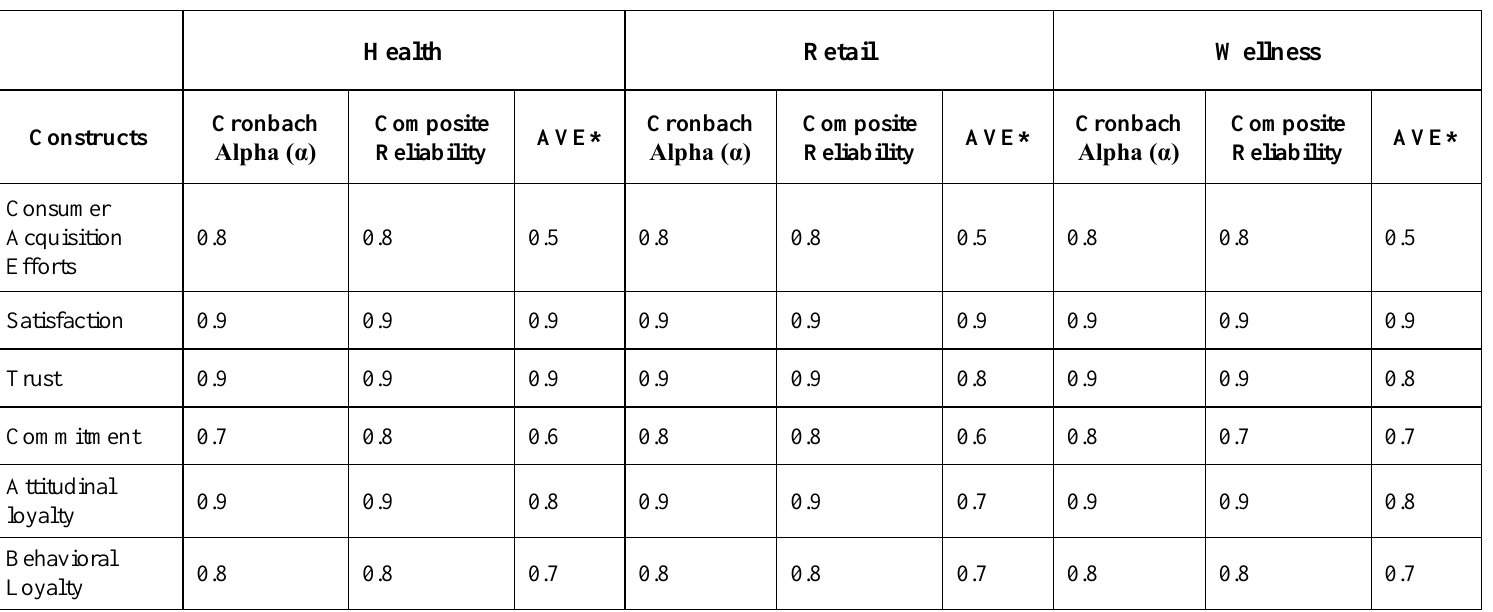
Table 03: Reliability and Validity Indexes